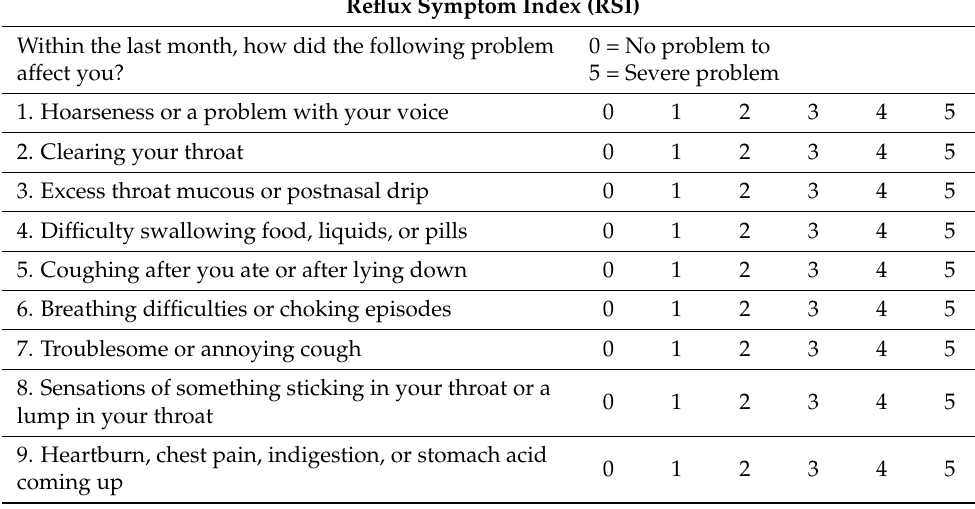
Table 1. Reflux symptom index